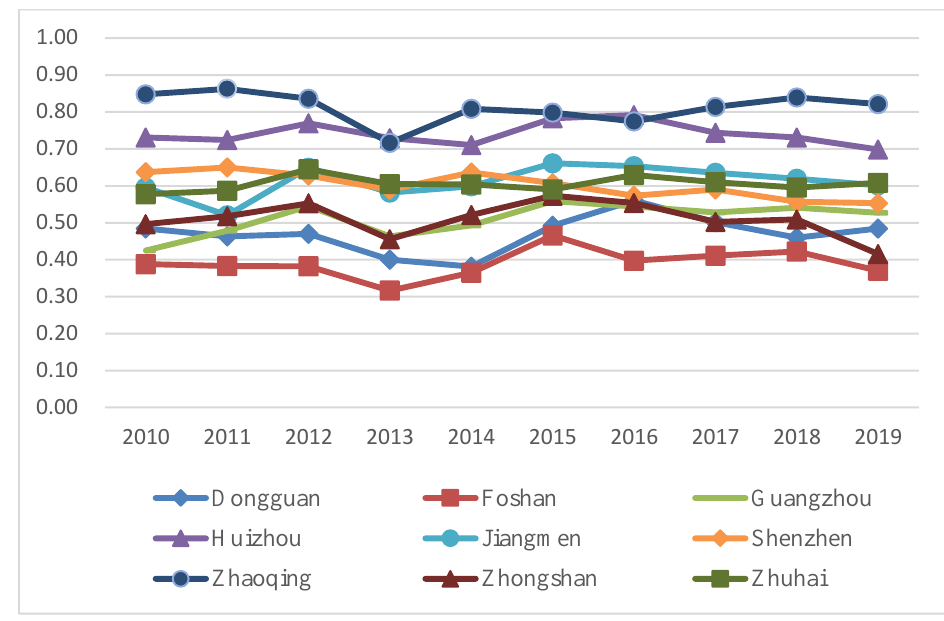
Figure 9. The benefit index of the eco-environment system in nine cities in the PRD.